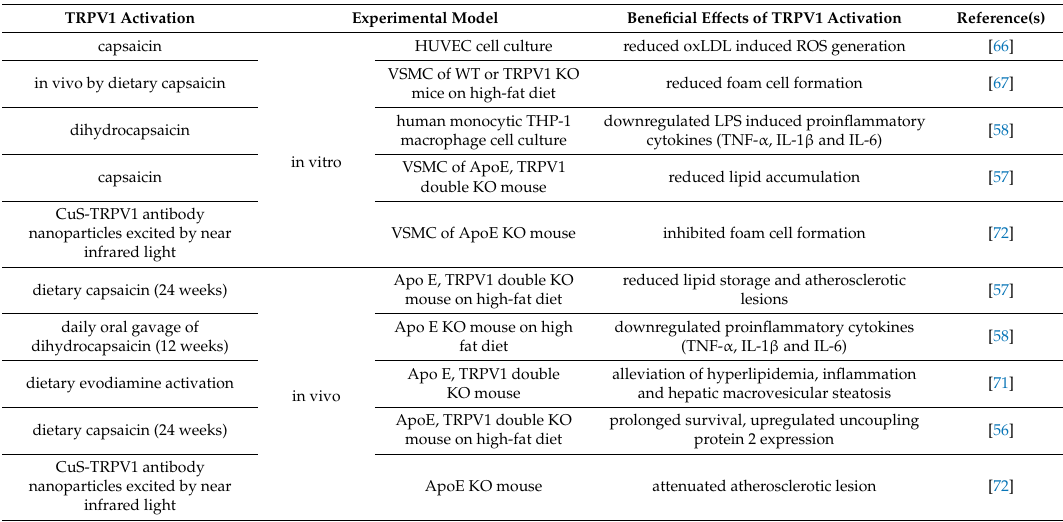
Table 1. Summary of the roles of TRPV1 channels in